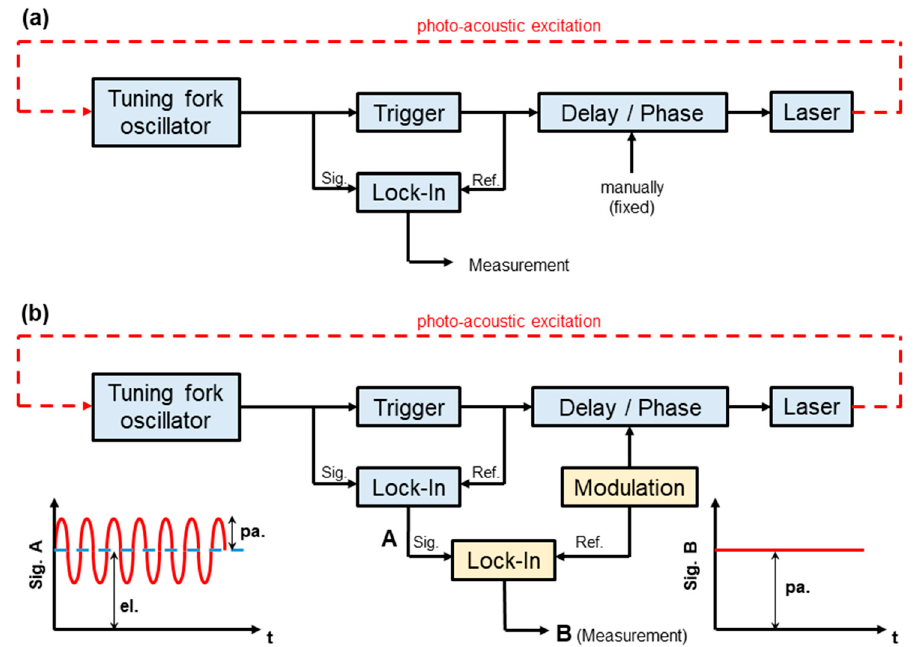
Figure 2. Schematic of the setup for modulation frequency auto tracking: ( a ) the tuning fork oscillator adjusts to the present resonance frequency. This is fed as reference to the lock-in amplifier and with a manually set (fixed) phase to the laser driver for modulation. The signal output at the lock-in is the sum of photoacoustic and electrical excitation. ( b ) A second lock-in amplifier is added to the setup and the phase of the laser modulation is modulated with a lower frequency. Thus the signal A of the first lock-in shows a sinusoidal variation (left inset). The second lock-in demodulates and amplifies this signal and yields a constant signal B (right inset) which is proportional to the sole photoacoustic excitation.